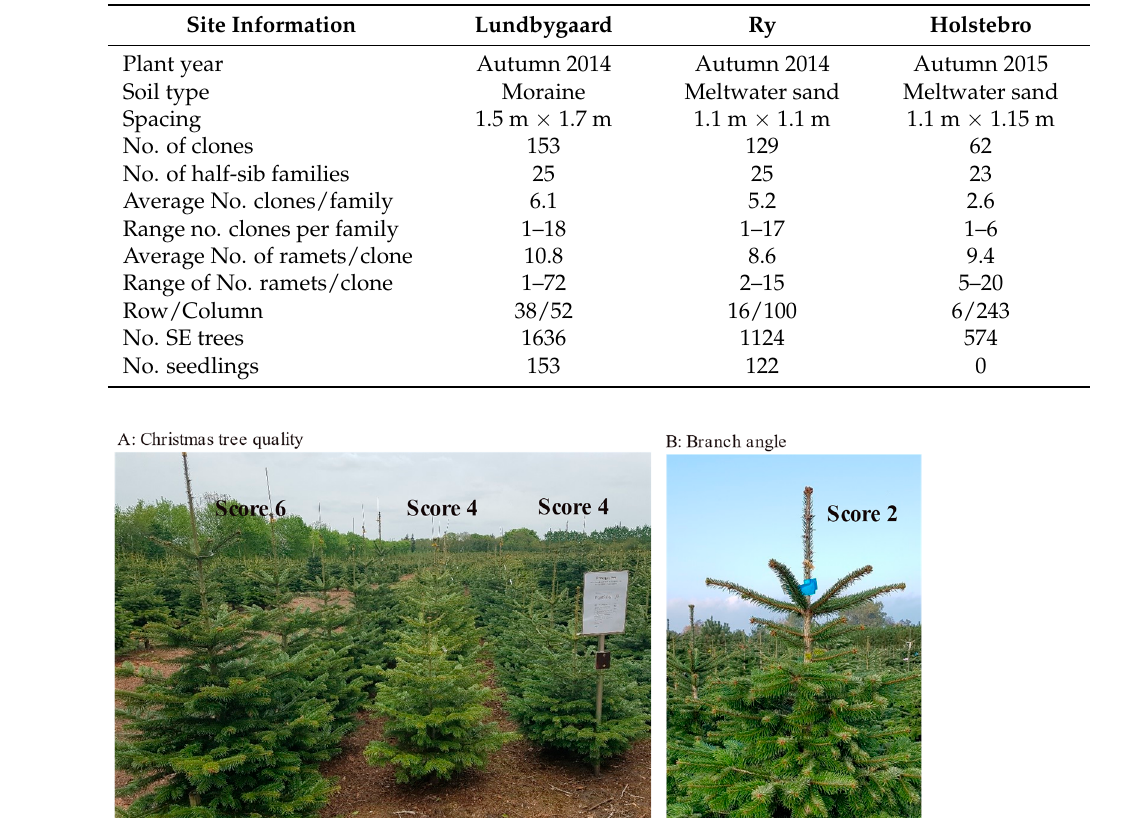
Table 1. Summary of site information.